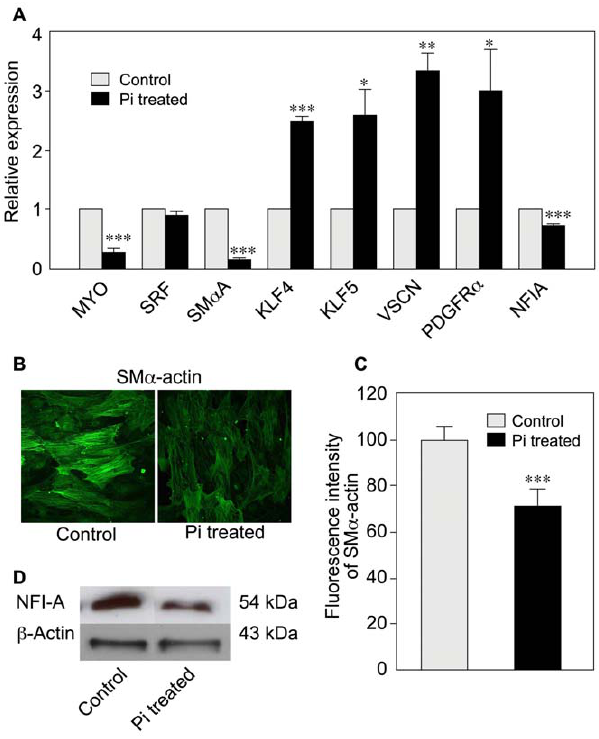
Figure 2. Elevated Pi affects VSMC phenotypic markers. VSMCs were cultured for 10 days in DMEM supplemented with 1% FBS, in the presence or absence of 3.5 mM Pi. (A) After RNA extraction, we performed RT-qPCR using specific primers for VSMC phenotypic marker genes. Contractile phenotype markers (such as myocardin (MYO) and Smooth muscle a –actin (SM a A) were highly downregulated), whereas synthetic phenotype markers like Kru¨ppel-like factor 4 (KLF4), KLF5, versican (VSCN) and platelet-derived growth factor receptor- a (PDGFR a ) were significantly upregulated (n=3). (B) Immunofluorescence of microscopic images showing the actin cytoskeleton after Pi treatment of VSMCs (magnification 40X), as also assessed (C) by fluorescence intensity measurements in corresponding histogram. (D) Representative immunoblot indicating the downregulation of NFIA in Pi-treated VSMCs. b -actin was used as endogenous control. One representative experiment shown out of two or three independent experiments.